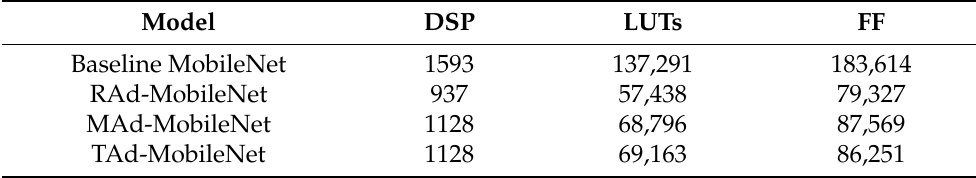
Table 3. Hardware resources of Ad-MobileNet model on varying the activation